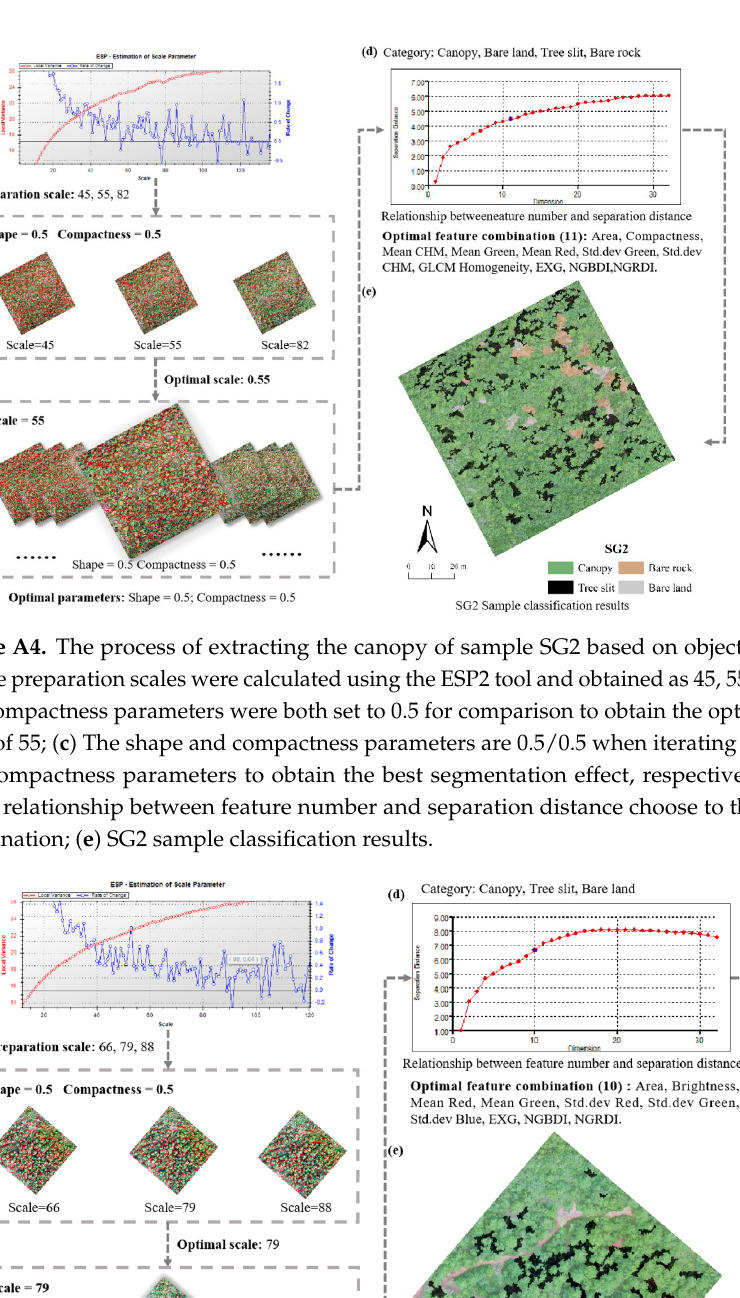
Figure A3. The process of extracting the canopy of sample SG1 based on object-oriented method. ( a ) The preparation scales were calculated using the ESP2 tool and obtained as 41, 63, 71; ( b ) The shape and compactness parameters were both set to 0.5 for comparison to obtain the optimal segmentation scale of 63; ( c ) The shape and compactness parameters are 0.5/0.6 when iterating through the shape and compactness parameters to obtain the best segmentation effect, respectively; ( d ) According to the relationship between feature number and separation distance choose to the optimal feature com- bination; ( e ) SG1 sample classification results.